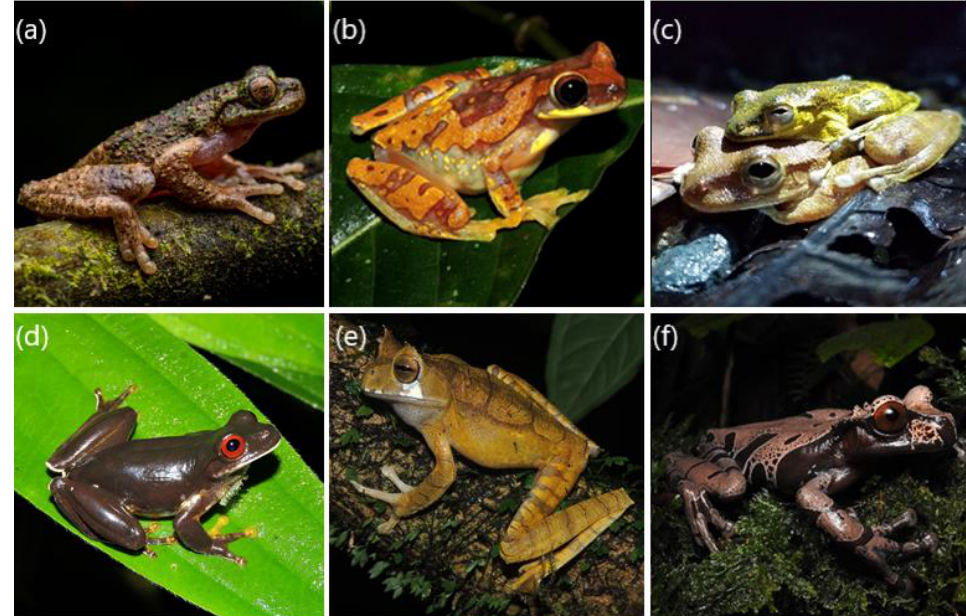
Figure 6. Spread patterns. Species recovery: ( a ) the Starret ’ s treefrog, Isthmohyla tica ; (picture, Jerson Santamaría and Pablo Marín) seems to be slowly recovering in part of its range. Rapid spread: ( b ) the harlequin treefrog, Dendropsophus ebraccatus (picture, Víctor Acosta-Chaves) and ( c ) the drab treefrog, Smilisca sordida (picture, Héctor Zumbado-Ulate) seem to have increased their ranges since the 2000s or earlier, perhaps taking advantage of the decline of other sympatric species. Widespread uncommon species: ( d ) the Legler’s treefrog, Duellmanohyla legleri , (picture, V i ctor Acosta-Chaves), ( e ) the horned treefrog, Gastrotheca cornuta (picture, Stanley Salazar), and ( f ) the spiny-headed treefrog, Triprion spinosus (picture, Stanley Salazar) are uncommon species that have been more frequently sighted in the last decade. Reproduced with permission from Jerson Santamaría and Pablo Marín.